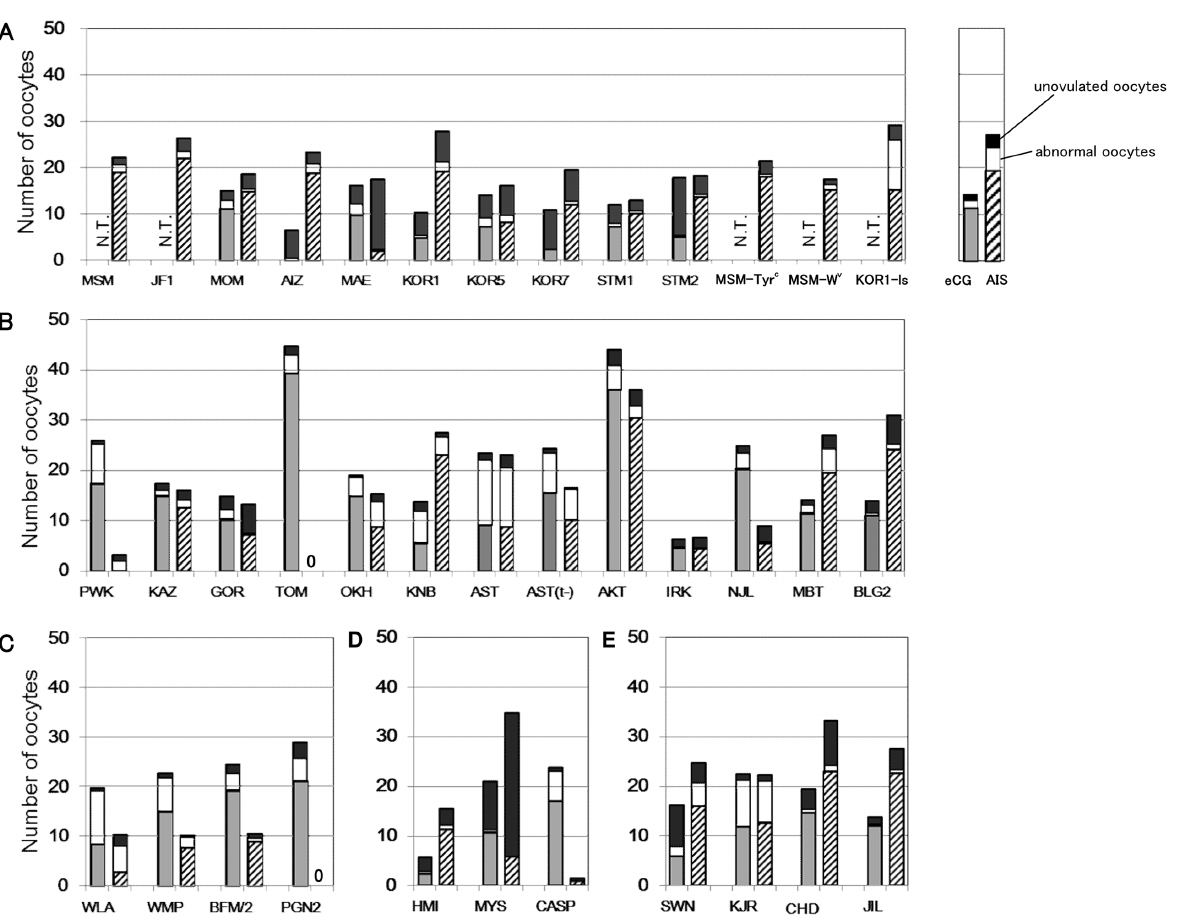
Figure 1. The mean numbers of oocytes collected per female after eCG or AIS treatment. Each bar shows the total number of oocytes consisting of normal ovulated oocytes (gray or hatched), abnormally ovulated oocytes (white), and unovulated ovarian oocytes (black). In 34 out of 37 strains, more than 15 oocytes per female were obtained either by eCG or AIS superovulation treatment. In M. m. molossinus , the strains known to be highly poor responders to eCG were not tested for eCG to save the number of animals used (shown as N.T.). The detailed data are summarized in Table S1.